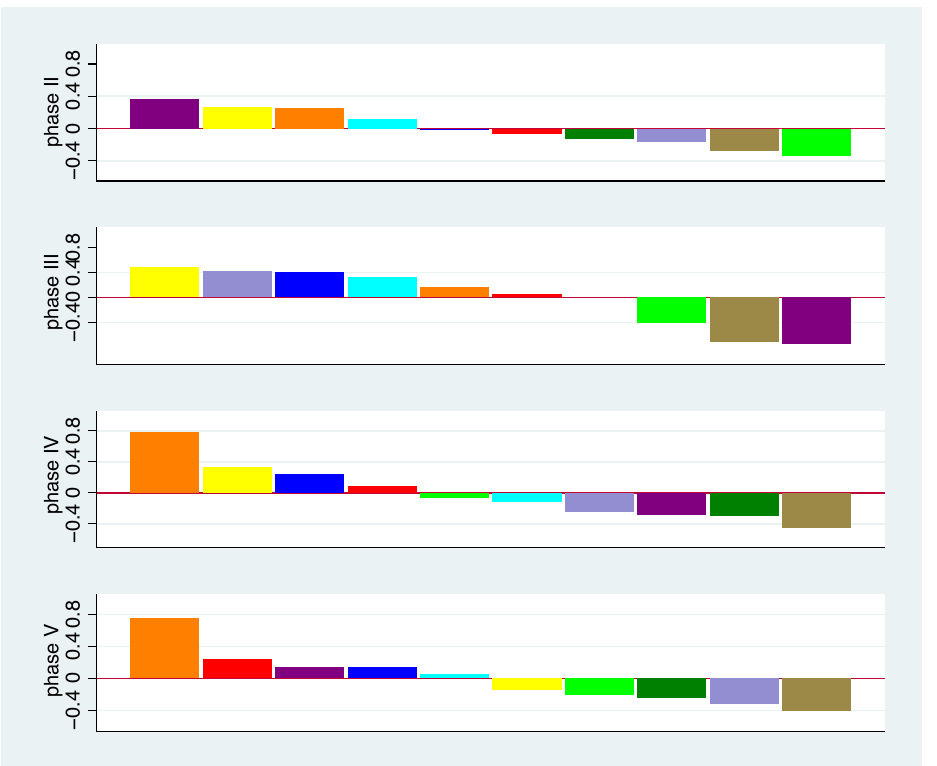
Figure 10. Mean values of average log ratio changes sorted for bacterial groups 1 to 10 for phase II ( top ) to phase V ( bottom ). For colour scheme, see Figure 1.